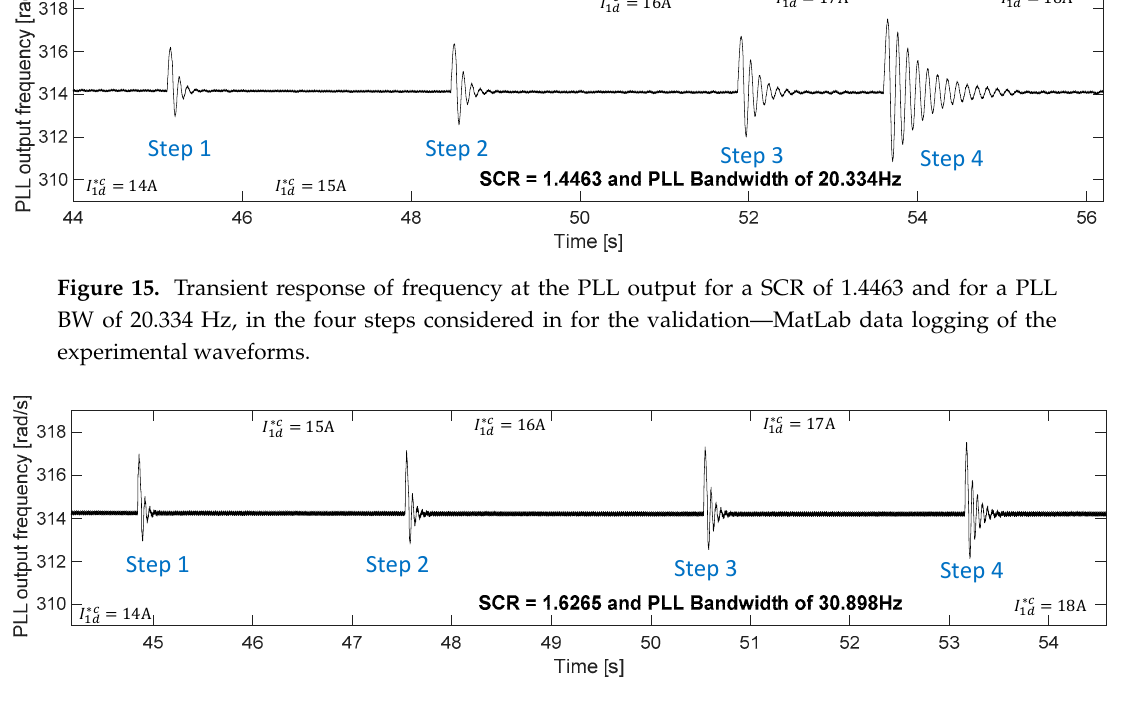
Figure 15. Transient response of frequency at the PLL output for a SCR of 1.4463 and for a PLL BW of 20.334 Hz, in the four steps considered in for the validation—MatLab data logging of the experimental waveforms. Table 7. Comparison between the damping of modes 7 and 8 given by the proposed model and the those found in the experimental system, for a SCR = 1.4463 and PLL bandwidth equal to 20.344 Hz.